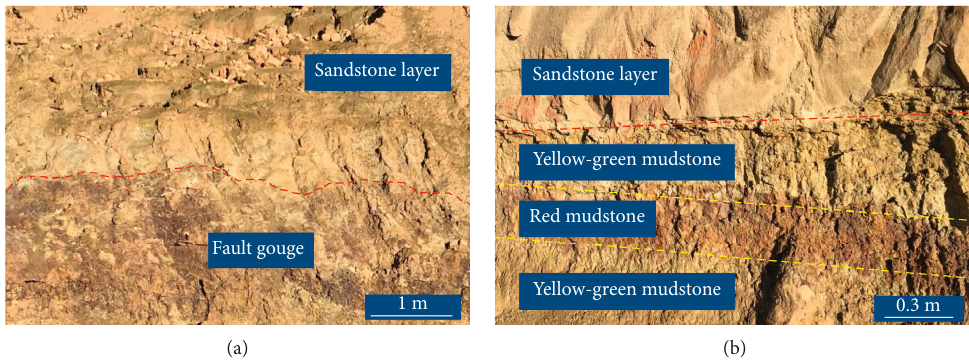
Figure 3: Strata characteristics of the fault zone and nonfault